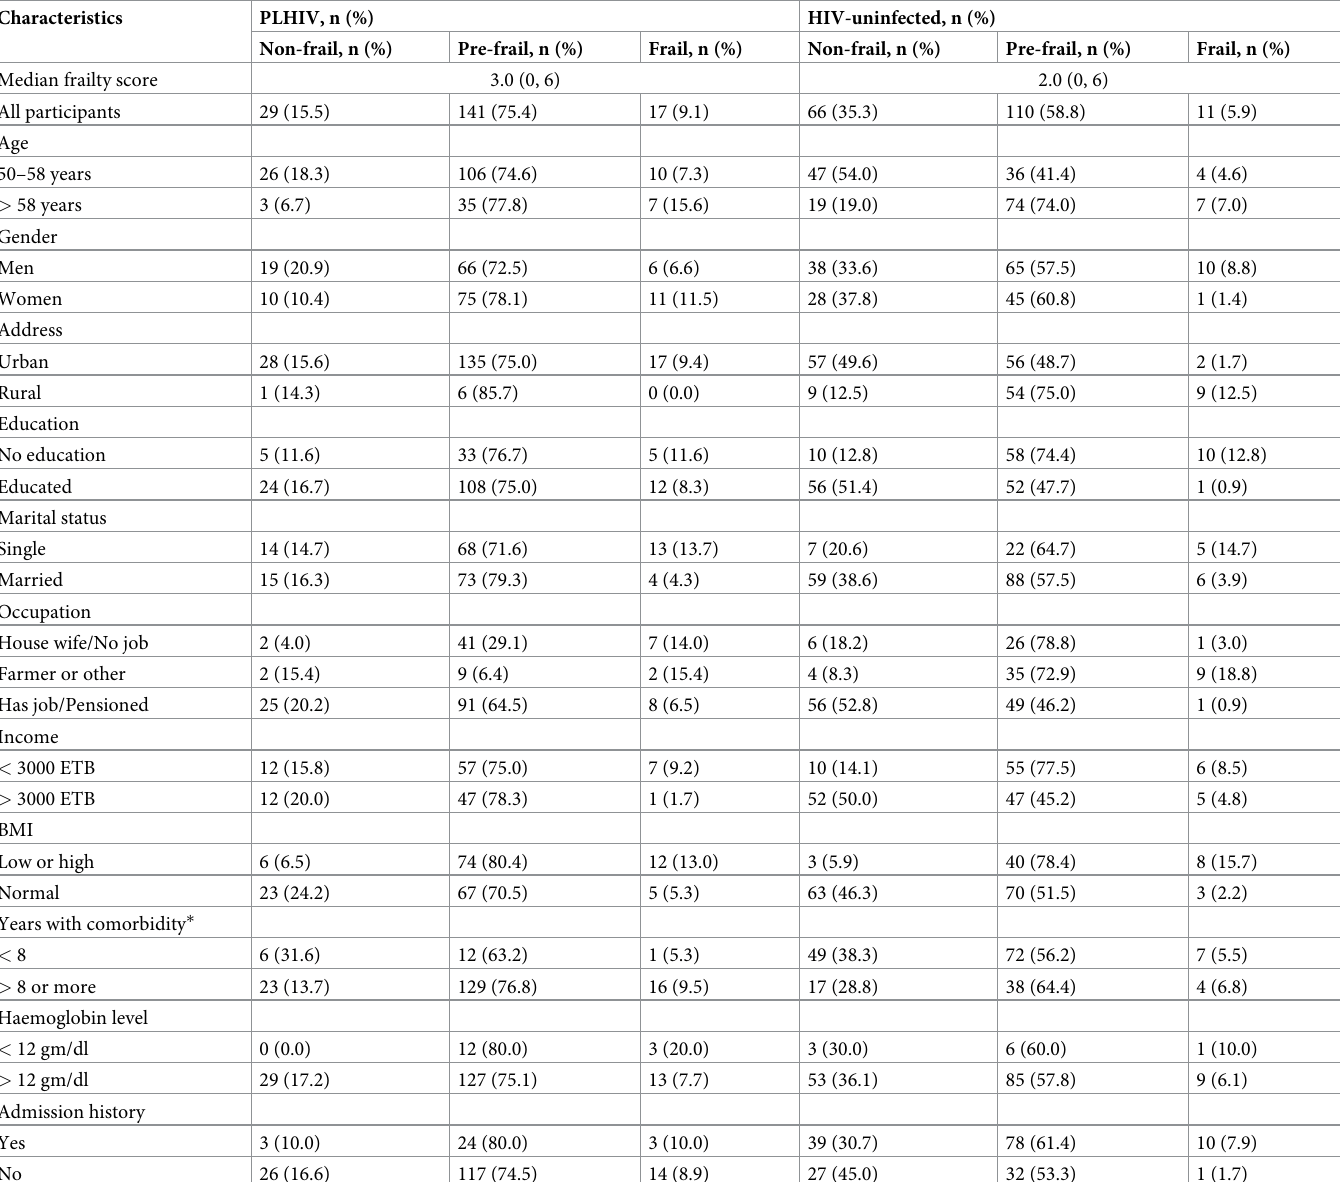
Table 3. Proportion of frail, pre-frail and non-frail among PLHIV and HIV-negative patients by various characteristics.